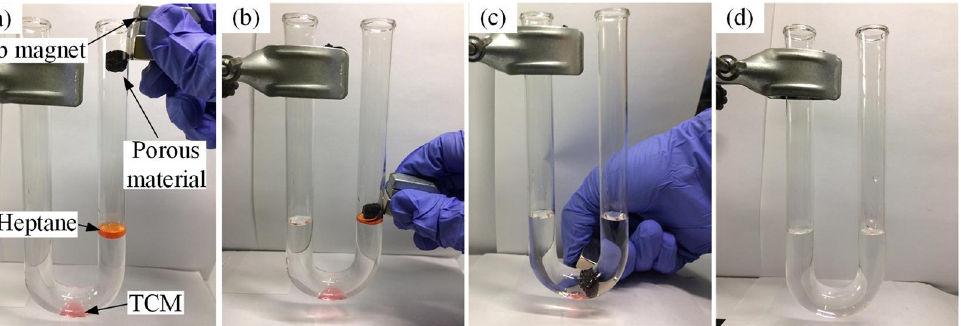
Figure 6: Oil/water separation tests of the HMSsample in a curved glass tube under the actuation ofa permanent magnet. ( a ) HMS sample driven by a permanent magnet; ( b ) HMS sample absorbed n - Heptane completely; ( c – d ) HMS sample absorbed TCM completely and left a clear